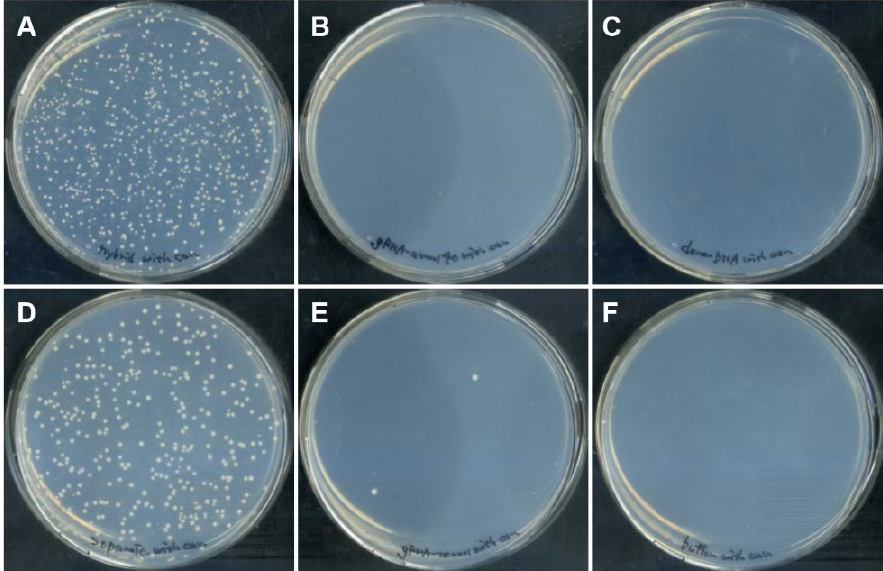
Figure 3. Colony formation on the canavanine-containing medium after DGybrid introduction. Yeast cells were subject to electroporation of the nucleic acids; ( A ) DGybrid, ( B ) 5 ′ -40b-gRNA only, ( C ) ssODN only, ( D ) gRNA and ssODN, ( E ) gRNA only, and ( F ) neither gRNA nor ssODN.